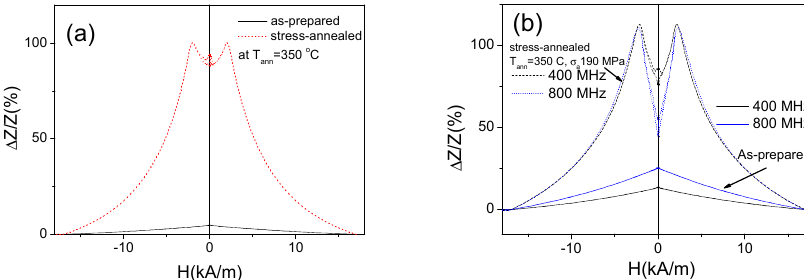
Figure 15. ∆ Z / Z ( H ) dependencies observed in as-prepared and stress-annealed at T ann = 350 ◦ C for σ a = 190 MPa Fe 75 B 9 Si 12 C 4 microwires ( f = 200 MHz) ( a ) and the same dependencies measured at 400 and 800 MHz ( b ).